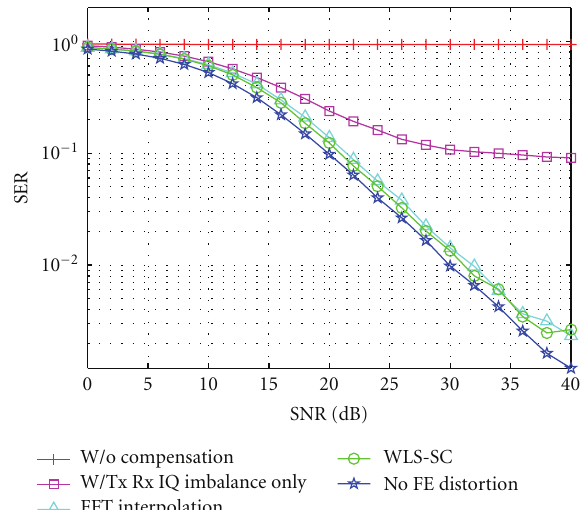
Figure 10: Sparse pilot-based SER versus SNR performance curves for 64-QAM OFDM system. Tx/Rx FE IRR = 20–30 dB; veh. A channel model with 39 taps; ensemble average over 1000 independent channel